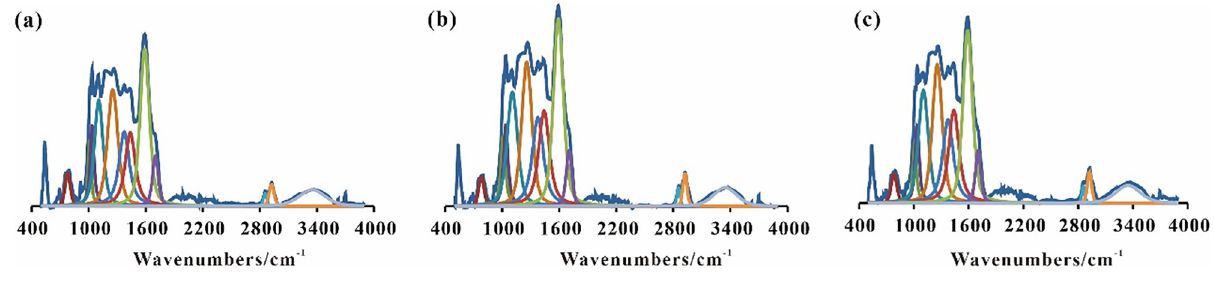
Fig 4. FTIR fitting of different functional groups in M0 (a), M1 (b), M2 (c).